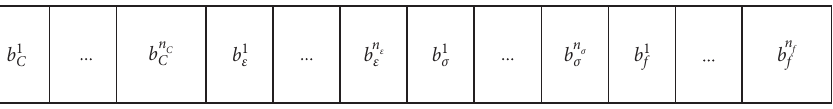
Figure 2: Encoding of DA-VNS